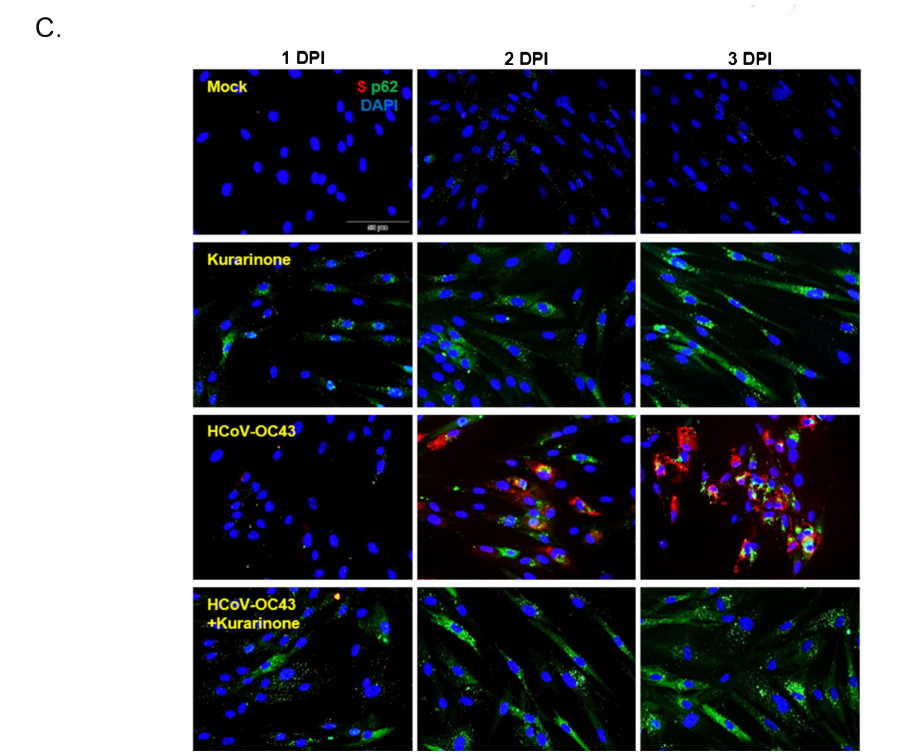
Figure 5. Expression of p62 / SQSTM1 protein in response to administration of kurarinone; ( A ) HCoV-OC43-infected MRC-5 cells were treated with kurarinone or vehicle for 2 or 3 days; Western blot was performed with anti-p62 / SQSTM1, -LC3, and -viral Spike antibodies at 2 or 3 dpi. ( B ) Virus-infected MRC-5 cells treated with kurarinone or vehicle alone were harvested at 3, 6, 24 or 48 h post-infection (hpi); cell lysates were analyzed by Western blot. Data were presented as means of two independent experiments. ( C ) Immunofluorescence analysis of HCoV-OC43-infected MRC-5 cells treated with vehicle (vhc) or kurarinone; cells were probed with an anti-viral Spike protein-specific antibody (red), p62 / SQSTM1 protein-specific antibody (green) and DAPI (blue) at 1, 2, and 3 dpi. Scale bar is 50 µ